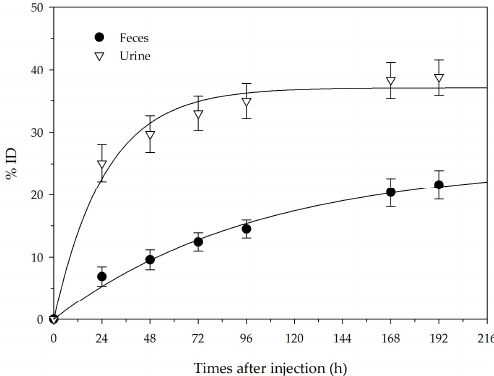
Figure 4. Cumulative urinary and fecal excretion of 111 In-DOTA-EB-cRGDfK after the intravenous administration. Each point represents the mean ± SD for five animals.